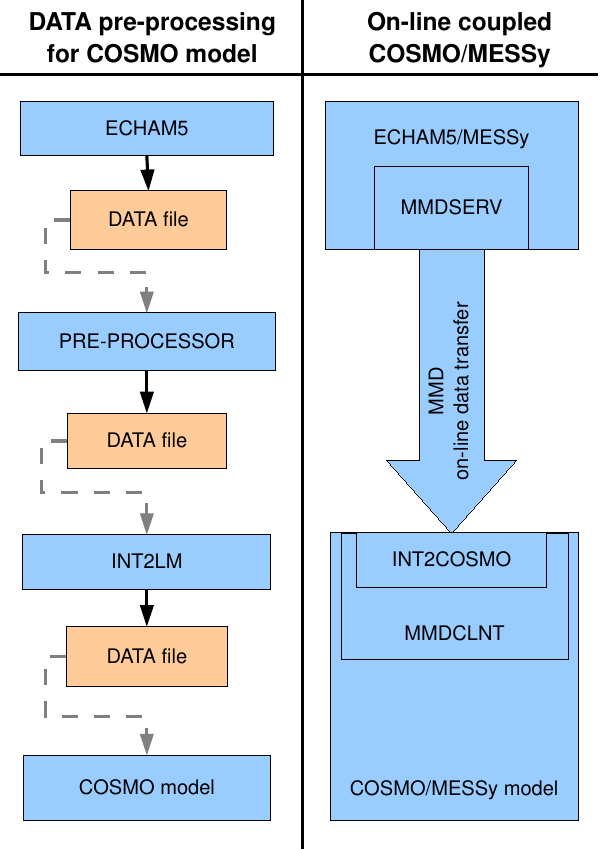
Fig. 2. Comparison of the data (pre-)processing procedure pro- viding boundary data for one time step to one instance of the stand-alone COSMO model (left) and of the on-line coupled COSMO/MESSy model using ECHAM5/MESSy as driving model (right). The stand-alone COSMO model requires four indepen- dent sequential tasks. First, the driving model ECHAM5 is run. Second, the output files of ECHAM5 are used as input to a pre- processing tool converting the ECHAM5 data to a format readable by INT2LM. Third, the pre-processor INT2LM calculates and out- puts the initial and boundary files for the COSMO model, which, fourth, is run to perform the intended simulation. In the on-line cou- pled model system the input data required for the COSMO model is exchanged on-line via the MMD library and interpolated on-line in the MESSy sub-submodel INT2COSMO. Thus no intermediate manual data processing is